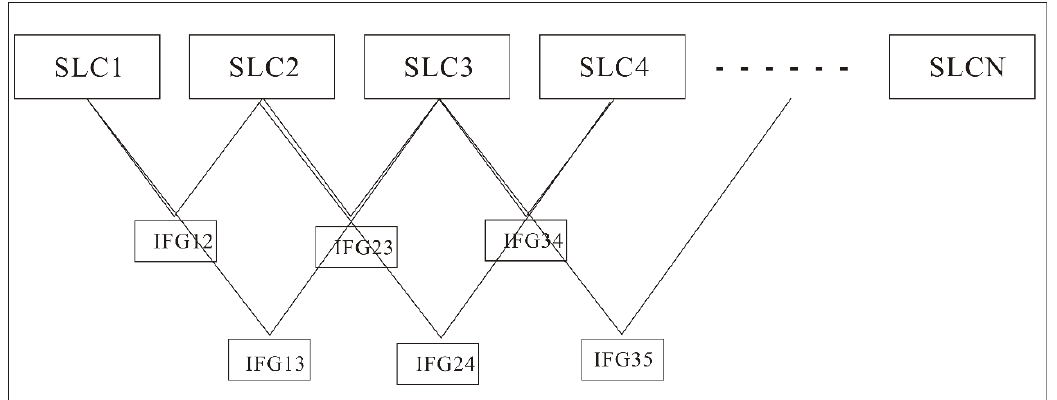
Figure 4. Schematic diagram of interference method.